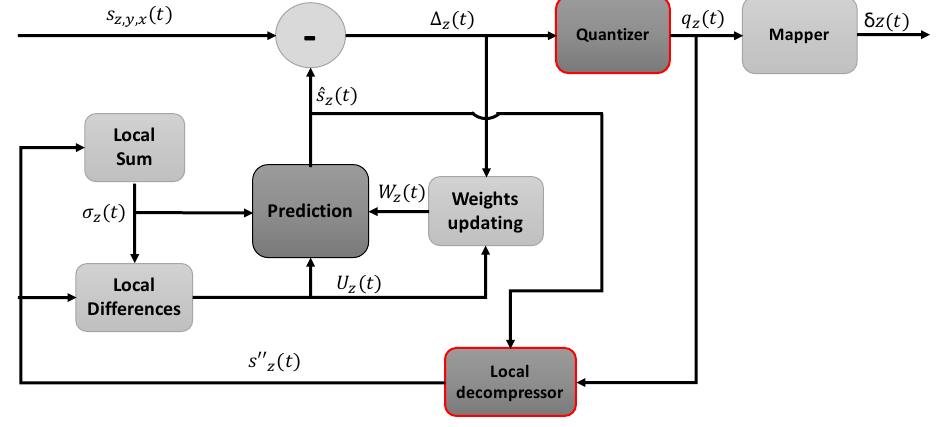
Figure 2. CCSDS 123.0-B-2 predictor